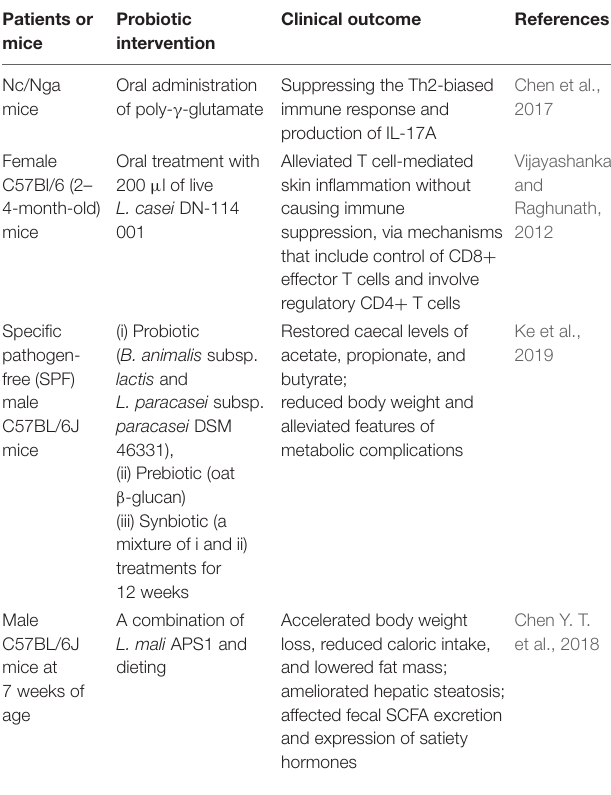
TABLE 4 | Potential probiotics and prebiotics for psoriasis